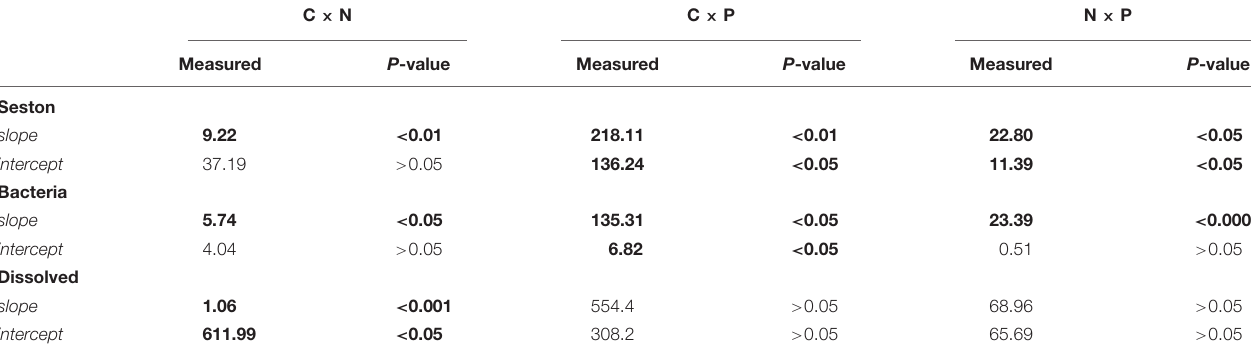
TABLE 3 | Comparison of slopes and intercepts between measured and expected Redfield relationships of pairs of nutrients (carbon, C, nitrogen, N and phosphorus, P) for seston, bacterial and dissolved fractions for the 15 lakes along the trophic gradient. C × N C × P N × P Measured P -value Measured P -value Measured P -value Seston slope 9.22 < 0.01 218.11 intercept